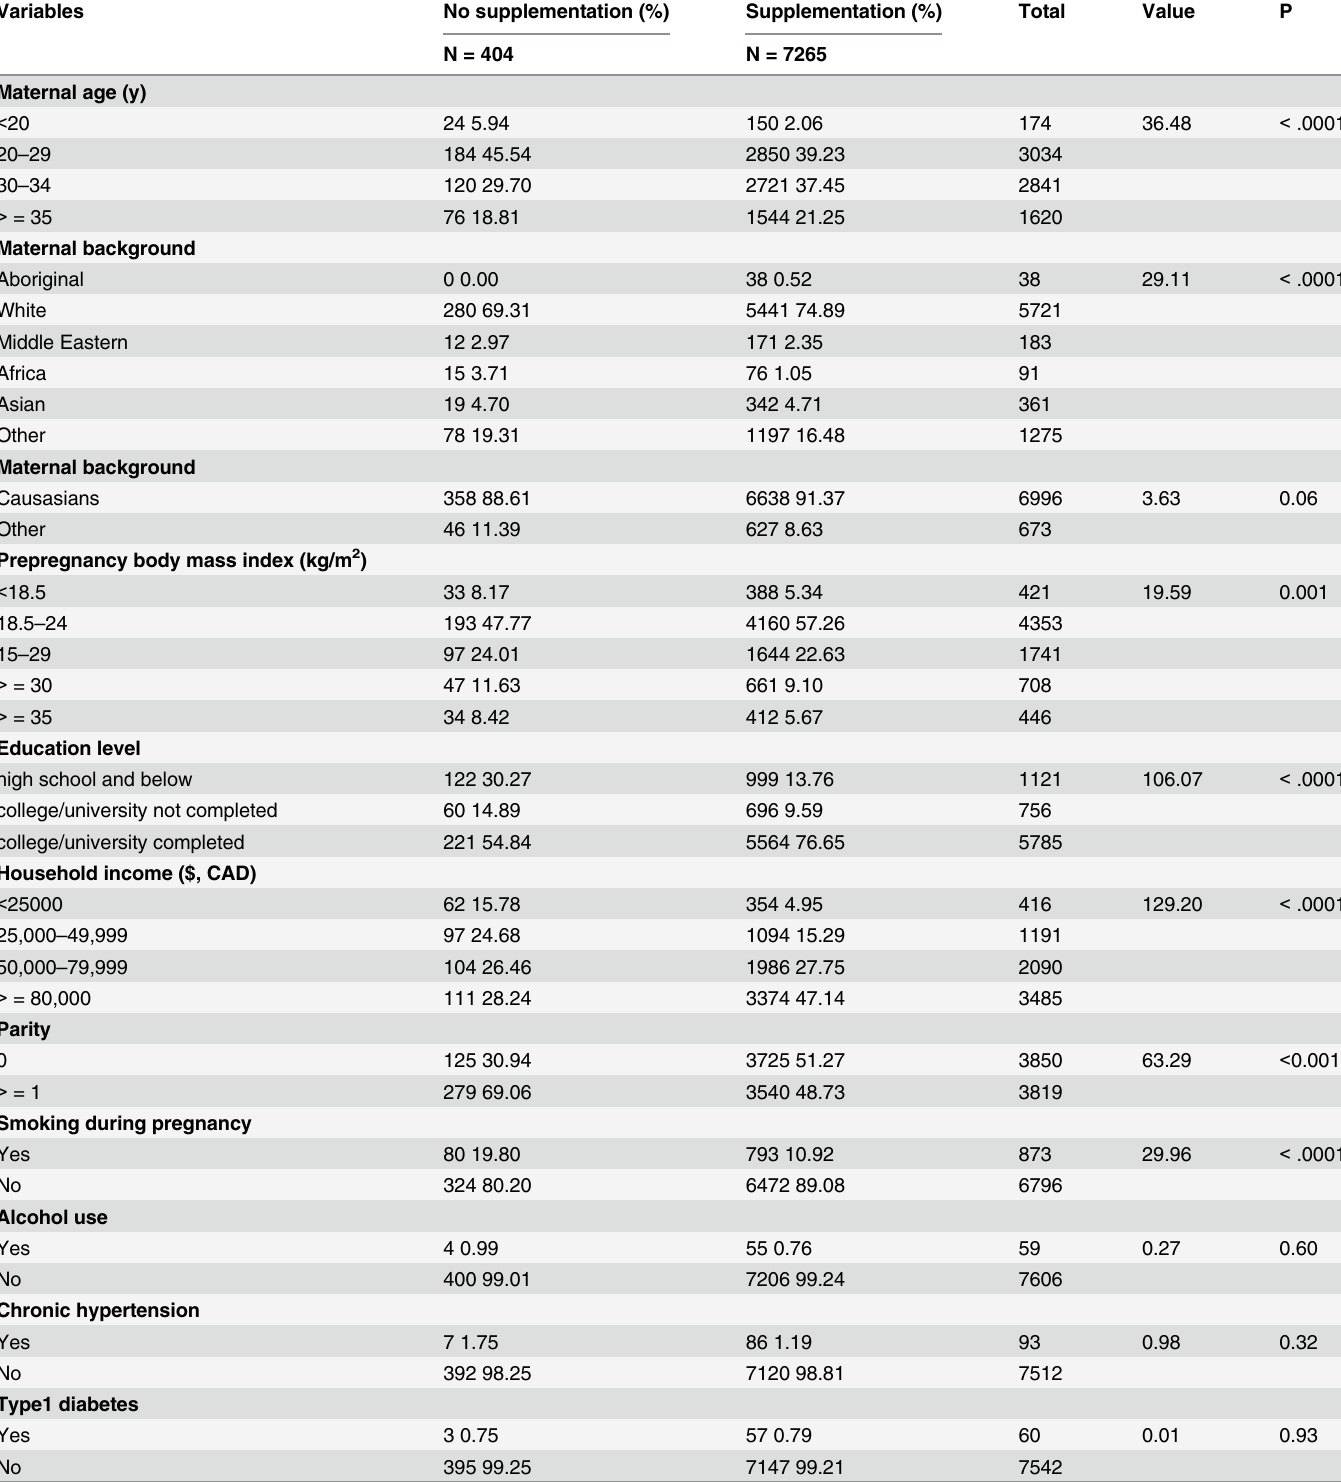
Table 2. Demographic and clinical characteristics of the pregnant women with and without folate supplementation who participated in the Oak Birth cohort